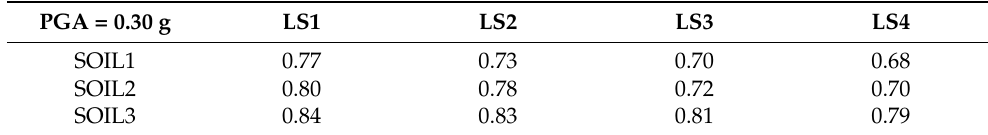
Table 8. PE at PGA = 0.30 g for various soil conditions and limit